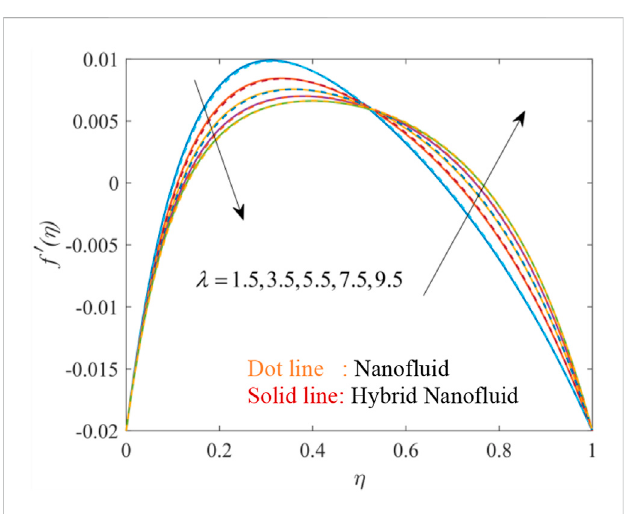
FIGURE 6 Effect of Magnetic fi eld parameter M on f ( η )